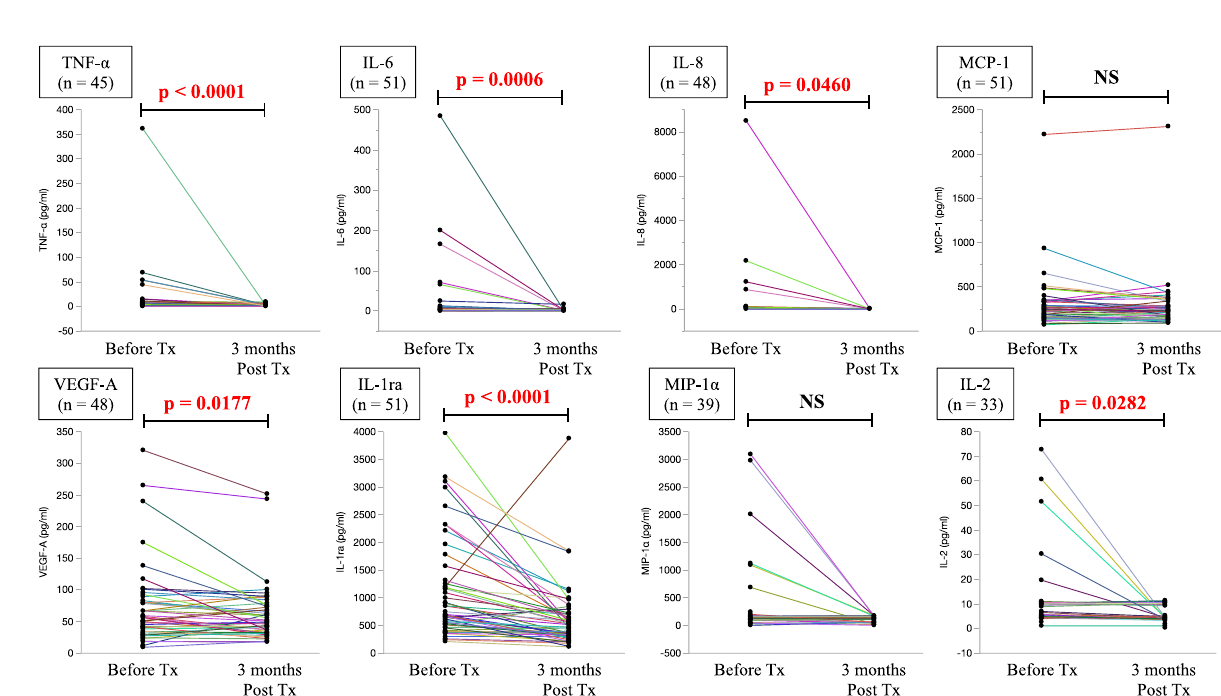
Figure 1. Serum cytokine levels before and after hydroxychloroquine treatment. Serum levels of the indicated cytokines and factors were measured before and after 3 months (3 M Post) of treatment (Tx) with hydroxychloroquine. Colored lines represent individual patients. p values were determined using the Wilcoxon signed-rank test. NS not